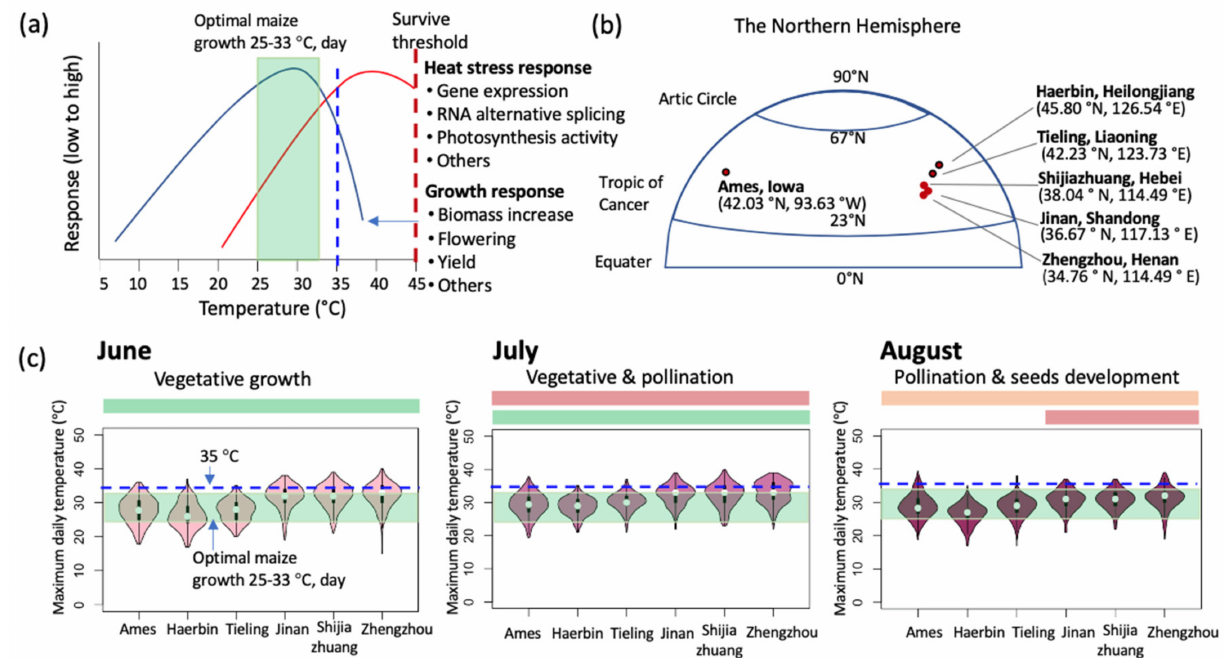
Figure 1. The relationship of temperature, growth, and heat stress in maize and the maximum temperature during maize vegetative growth and reproduction (June, July, and August) in six typical cities in the Chinese maize production region and the US corn belt. ( a ) Optimal growth conditions overlap with the onset of heat stress. The optimal temperature range for maize growth is 25–33 ◦ C day, (green box)/17–23 ◦ C, night. The trends of heat stress and growth responses shown here are from our experiments [7,8] conducted with the maize inbred line W22 grown under controlled environmental conditions in the Enviratron at Iowa State University. ( b ) The latitude distribution of the six cities for the comparison. Ames, United States corn belt; Haerbin and Tieling, in the Northeast maize production region of China, while Jinan, Shijiazhuang, and Zhengzhou in the Huang-Huai-Hai maize production region of China. ( c ) Violin plots show the maximum daily temperature during maize vegetative growth and reproduction (June, July, and August) in six typical cities in the Chinese maize production region and the US corn belt. Violin plots depict distributions of the 10 years’ maximum daily temperature in June, July and August collected for six cities used. Each violin plot is a combination of a box plot and a kernel density plot. In the middle of each density curve is a small box plot, with the rectangle showing the ends of the first and third quartiles and central dot the median. The width of each curve corresponds with the approximate frequency of data points in each region. The light green boxes in panels ( a , c ) indicate the range of the optimal maize growth temperature in the daytime. The blue dashed lines represent 35 ◦ C. Historical temperatures for Ames were sourced from https://www.wunderground.com/history (accessed on 18 January 2022) and the historical temperatures for the Chinese cities were sourced from http://tianqi.2345.com (accessed on 18 January